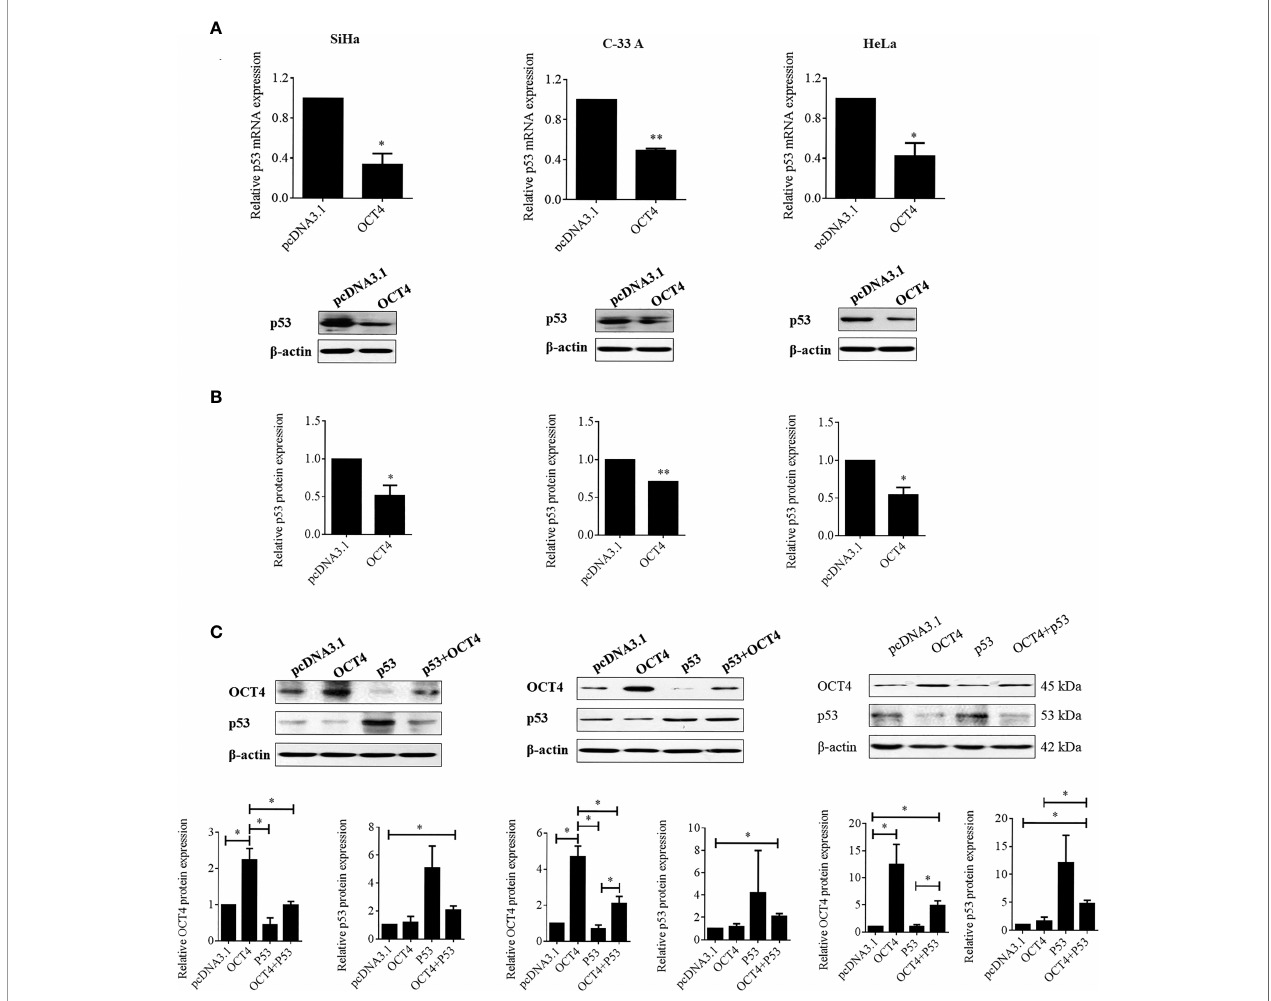
FIGURE 7 | OCT4 overexpression inactivated p53 expression in human cervical cancer cells. (A) The SiHa, C-33A, and HeLa cells were transfected with pcDNA3.1- OCT4 or pcDNA3.1 for 24 h. Then, p53 mRNA levels were determined by RT-PCR. (B) p53 protein levels were detected by Western blot in cells treated as in (A) . (C) The SiHa, C-33A, and HeLa cells were co-transfected with pcDNA3.1-OCT4 or pcDNA3.1-p53 or the empty vector pcDNA3.1 for 24 h. Then, the OCT4 and p53 protein levels were detected by Western blot. * p < 0.05, ** p < 0.01 vs.